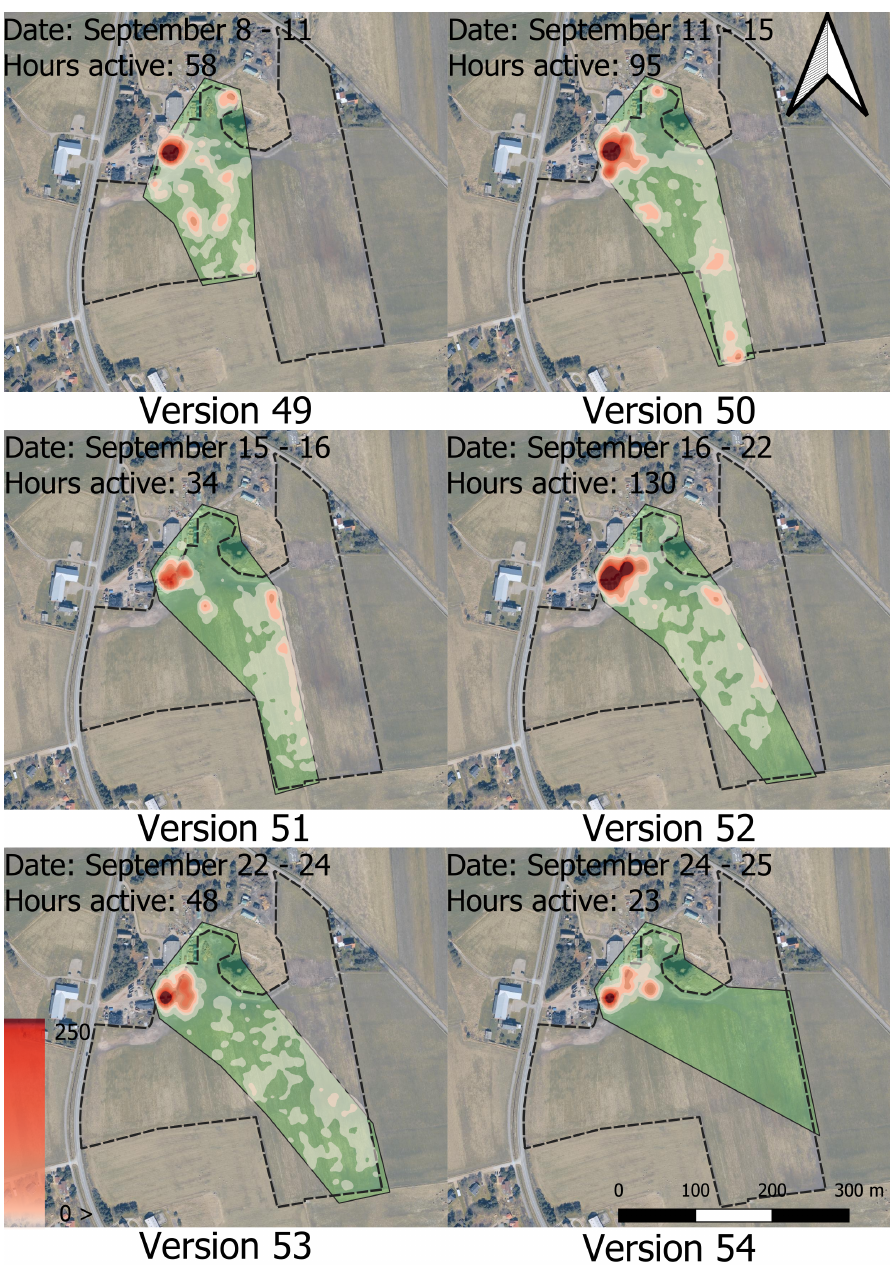
Figure A18. Heatmap series 9 visualising all Poll messages sent during the period from 8 September to 25 September. The green area shows the virtual enclosure area to which the bull calves were limited. The white to red colour indicates the number of Poll messages within a 10 m radius. The brightest colour represents the areas with the lowest density of Poll messages, while the darkest colour represents the areas with 250 or more Poll messages within the radius. The coordinates of the upper left corner of the map frame are 55°25 (cid:48) 23.131 (cid:48)(cid:48) E 8°23 (cid:48) 53.531 (cid:48)(cid:48) N. Contains data from the Agency for Data Supply and Infrastructure, Forårsbilleder Ortofoto-GeoDanmark, December